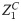
POC-RD plus carriage RD can reverse selection on pneumococcal resistance, even for long–carriage-duration serotypes.The parameter space generating net selection against resistance is plotted in blue as a function of the rate of carriage discovery (r1) and the effectiveness of carriage HTC (Z1C). (A) Longest–carriage-duration serotype (6B, median 20 weeks). (B) Shortest–carriage-duration serotypes (1, 4, 5; approximately 2 weeks). In both (A) and (B), 2 POC-RD scenarios are shown: with (f = 0.01) and without (f = 0) biological cost of resistance. The red dashed line represents the probability of strain 1 discovery while in the carriage state (“C1 discovery”), an increasing function of the rate of carriage diagnosis. The remaining parameters (rates per day) are d = 0.001, ϕ1C = 5 × 10−4, ϕ2C = 0, γ1I=γ2I = 1, γ0I = 0.125, γC = 0.006 (A), γC = 0.07 (B). We make the simplifying assumption that baseline carriage and infection transmission rates are identical (βI = βC = β), which ensures that the parameter space generating net selection against resistance does not depend on β. Details on parameterization are in S1G Text. The asterisk positions the outcome of an annual intervention with 50% efficacy in reducing C1 transmission. HTC, heightened transmission control; POC-RD, point-of-care resistance diagnostics.